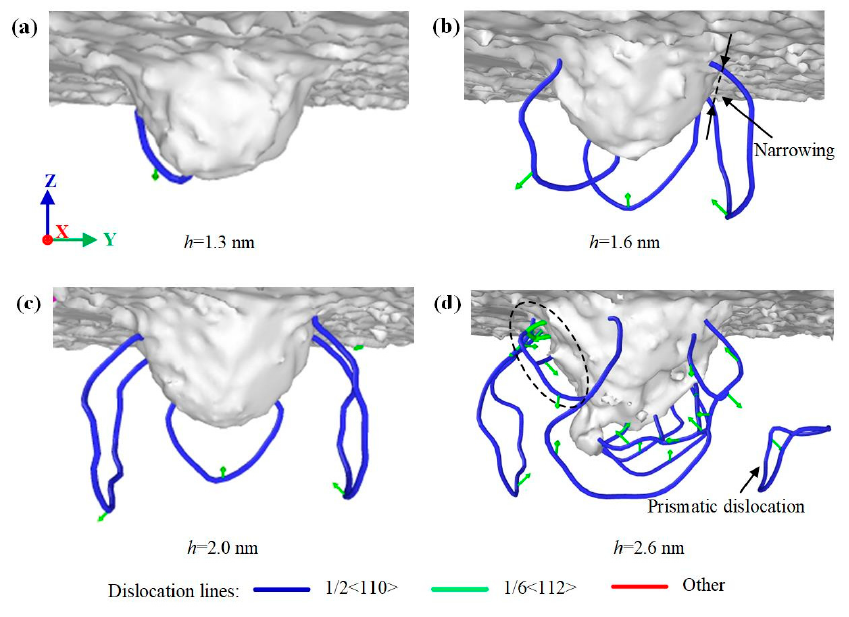
Figure 8. Dislocation distribution of 3C-SiC at different indentation depths: ( a ) h = 1.3 nm, ( b ) h = 1.6 nm, ( c ) h = 2.0 nm, and ( d ) h = 2.6 nm, respectively.